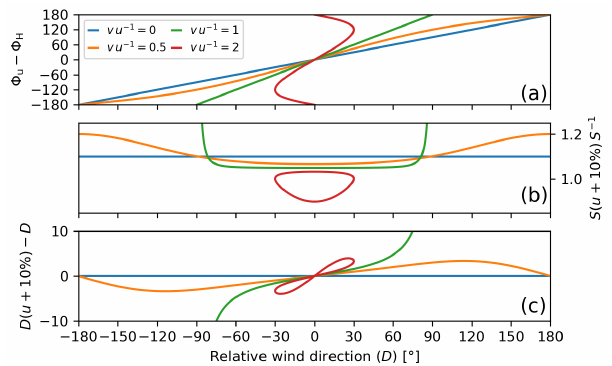
Figure B1. (a) Difference between true wind direction and ship heading as a function of the observable relative wind direction. (b) Relative change in the expected relative wind speed S M for a + 10% bias reference true wind speed ( u M ) as a function of the relative wind direction. Panel (c) is the same as (b) but shows the corresponding change in the estimated relative wind direction. The different coloured lines correspond to different ratios of the ship speed and the true wind